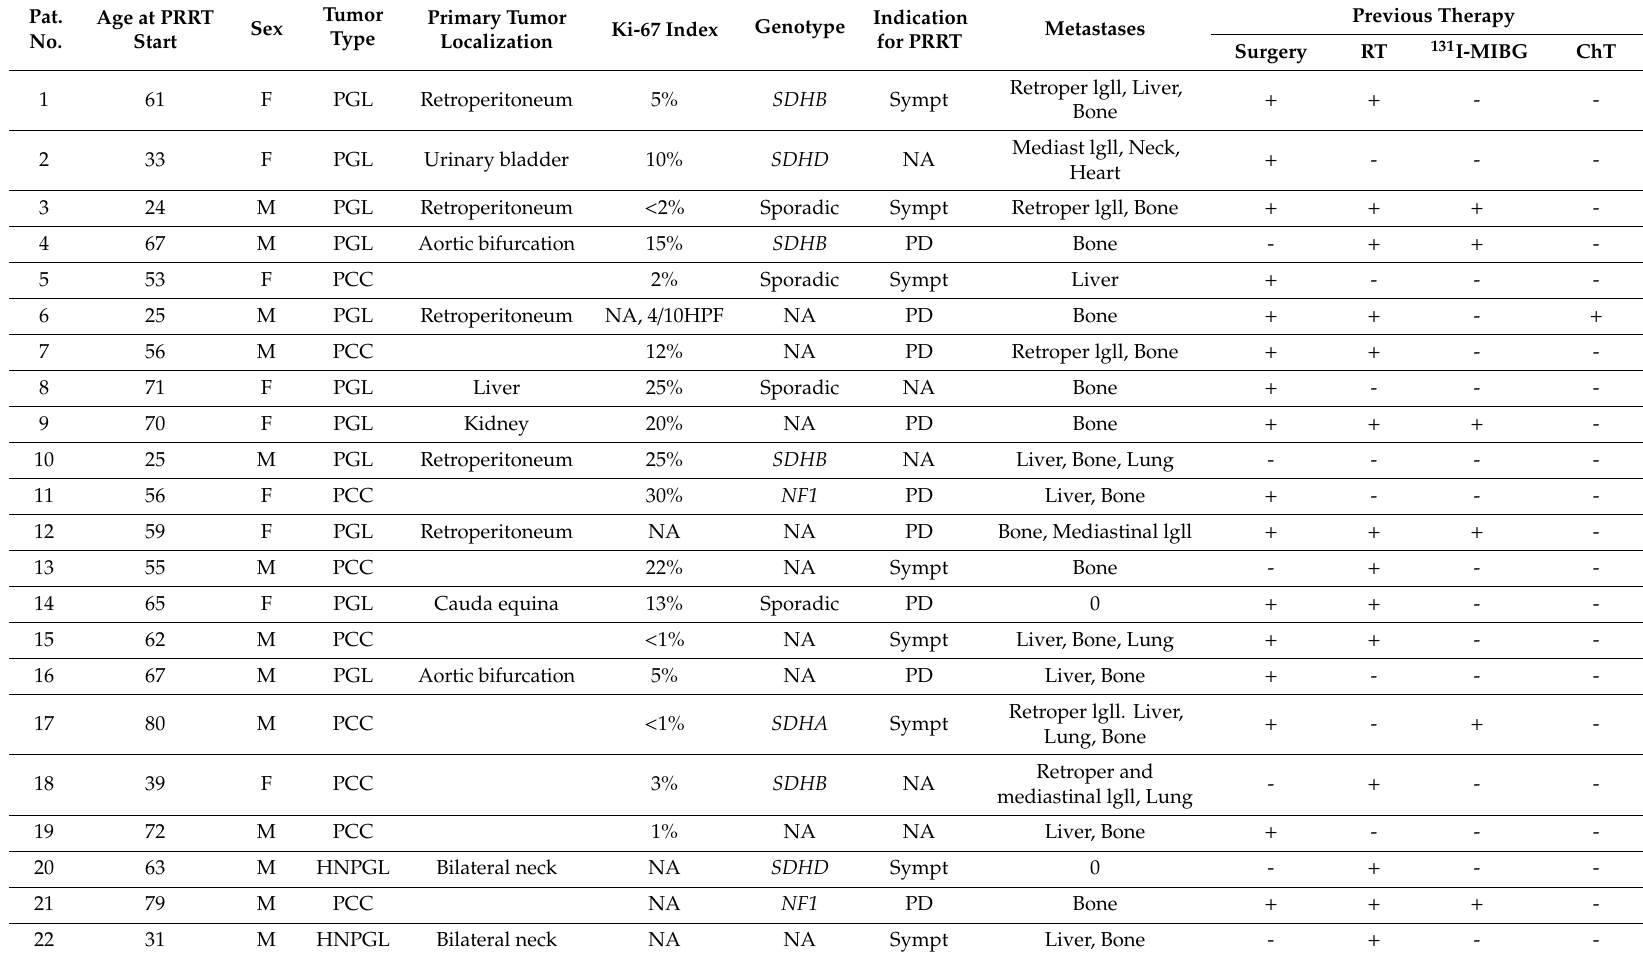
Table 1. Baseline patient